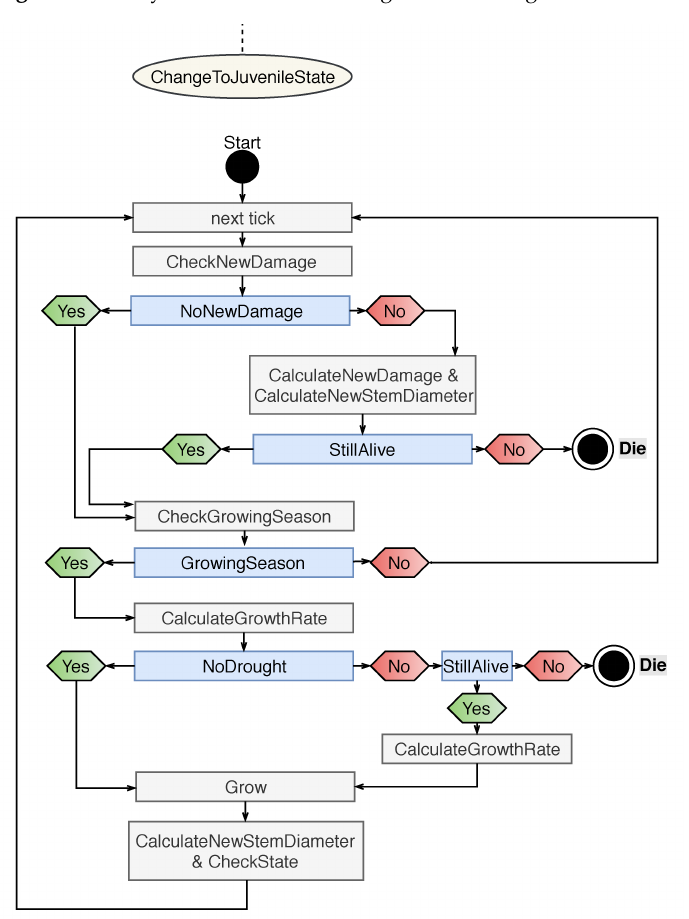
Figure A3. Daily tick routine for juvenile and adult